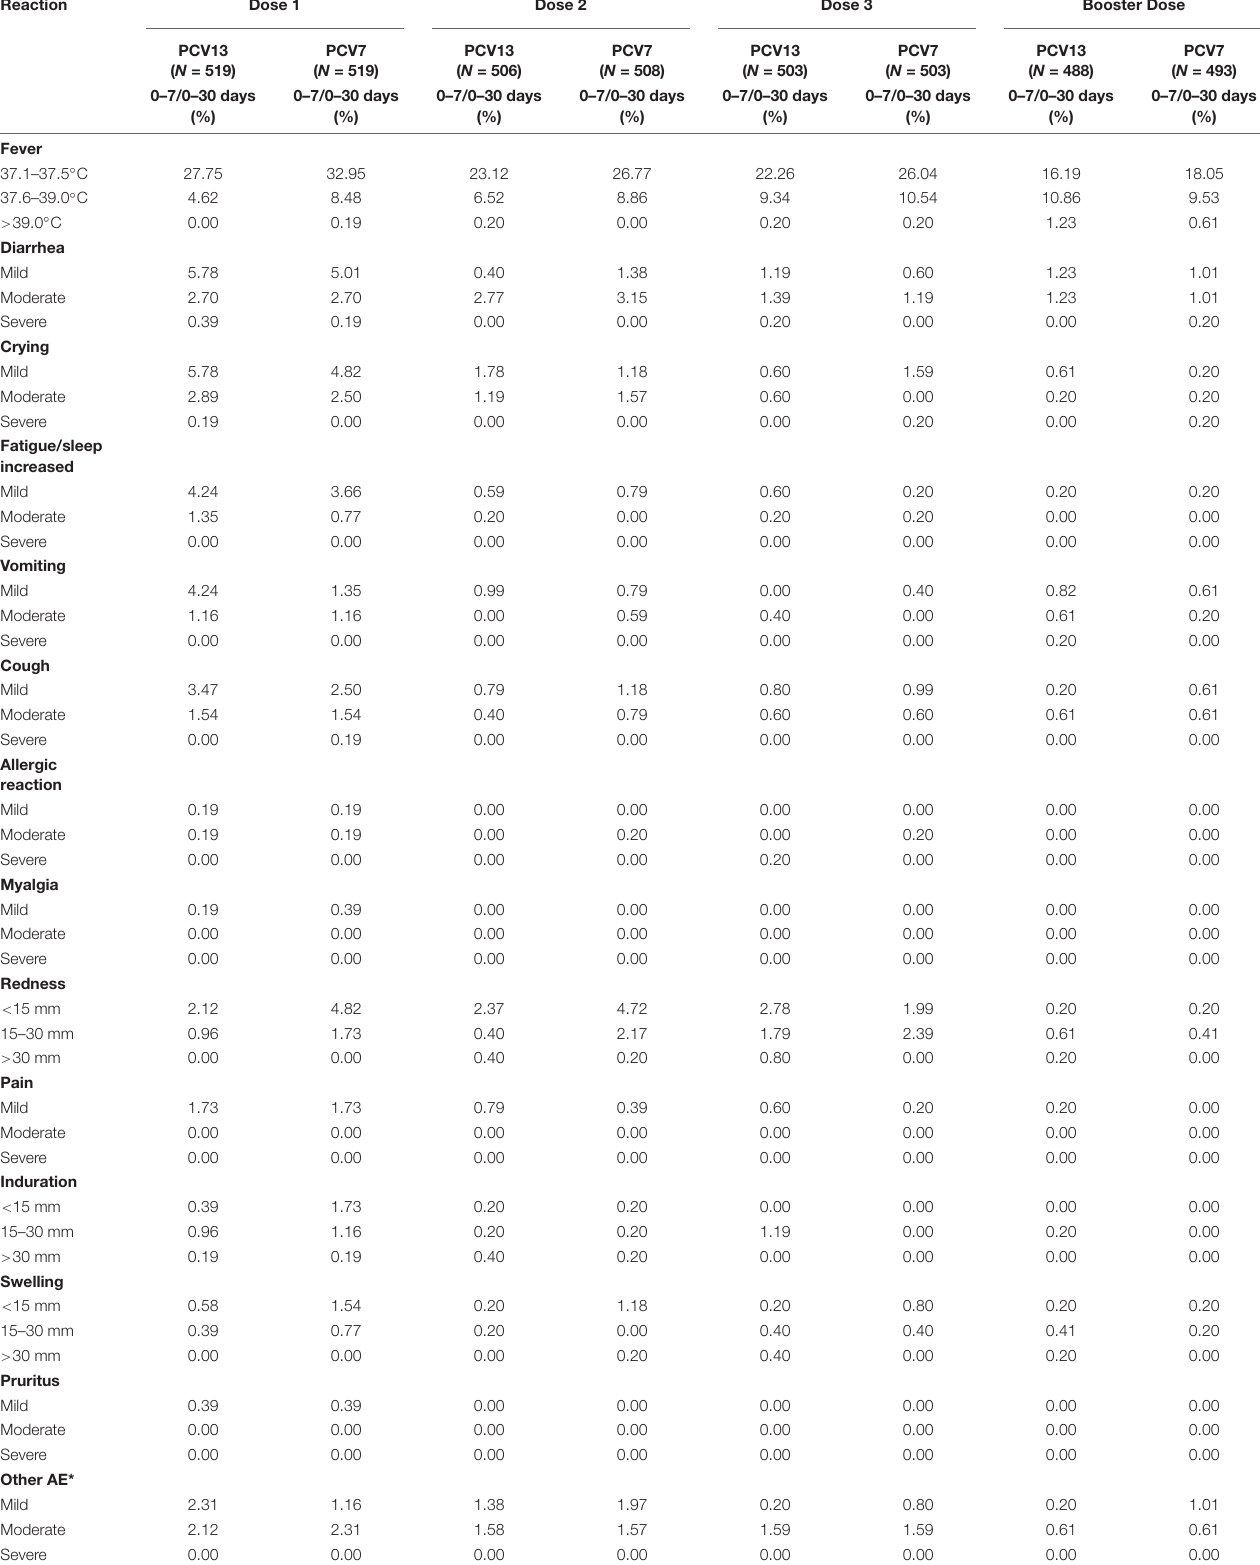
TABLE 6 | Percentage of subjects who reported local reactions, systemic events, and other AE after each dose. Reaction